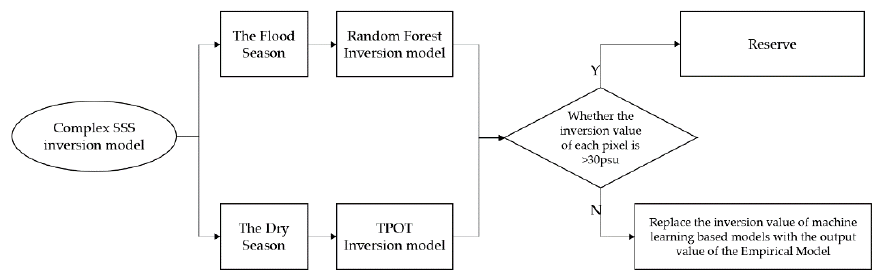
Figure 9. The process of SSS inversion based on the complex models.